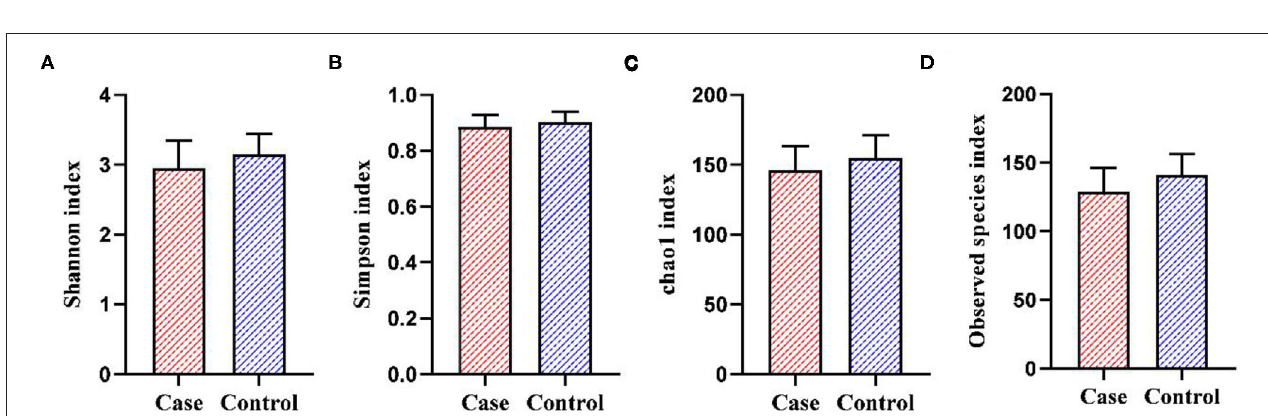
FIGURE 3 | The alpha-diversity of gut microbiota between the two groups. (A) Shannon index. (B) Simpson index. (C) Chao1 index. (D) Observed species index.